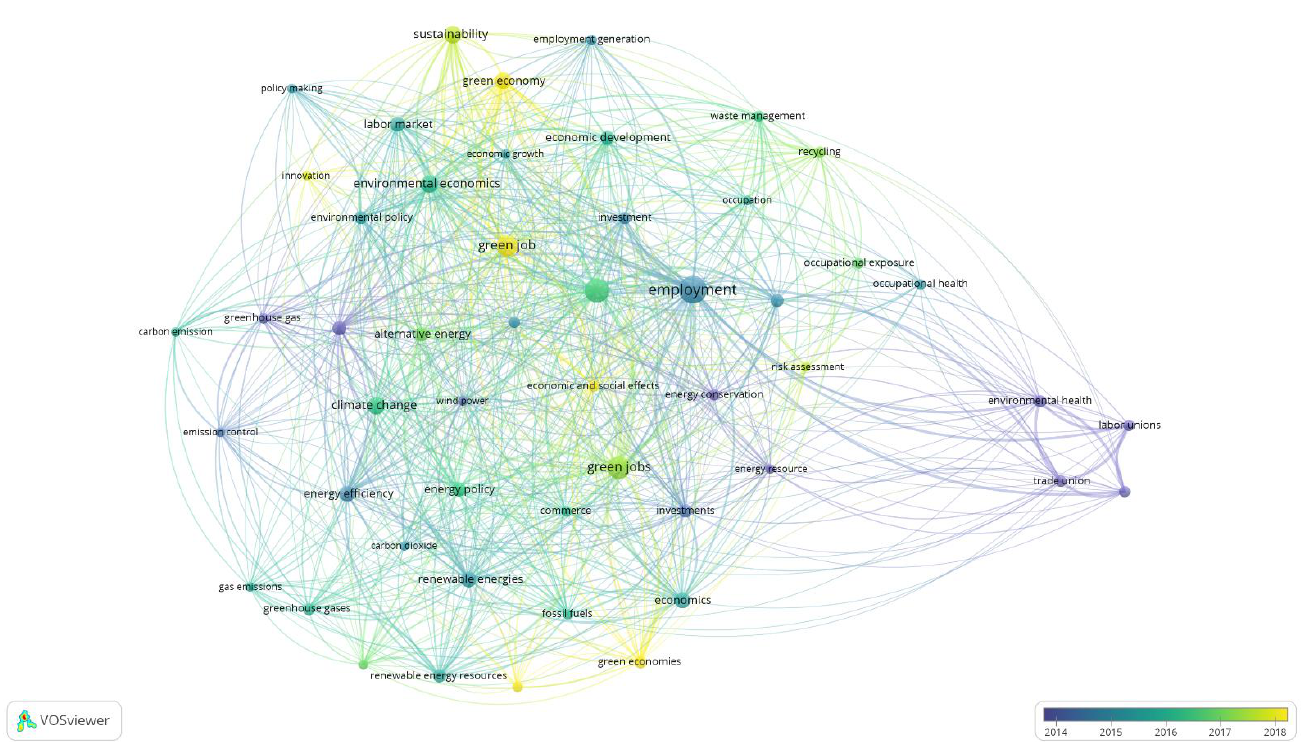
Figure 5. Overlay Visualization of keywords co-occurrences Q5 results analysis in Scopus. Source: Authors ’ elaboration.